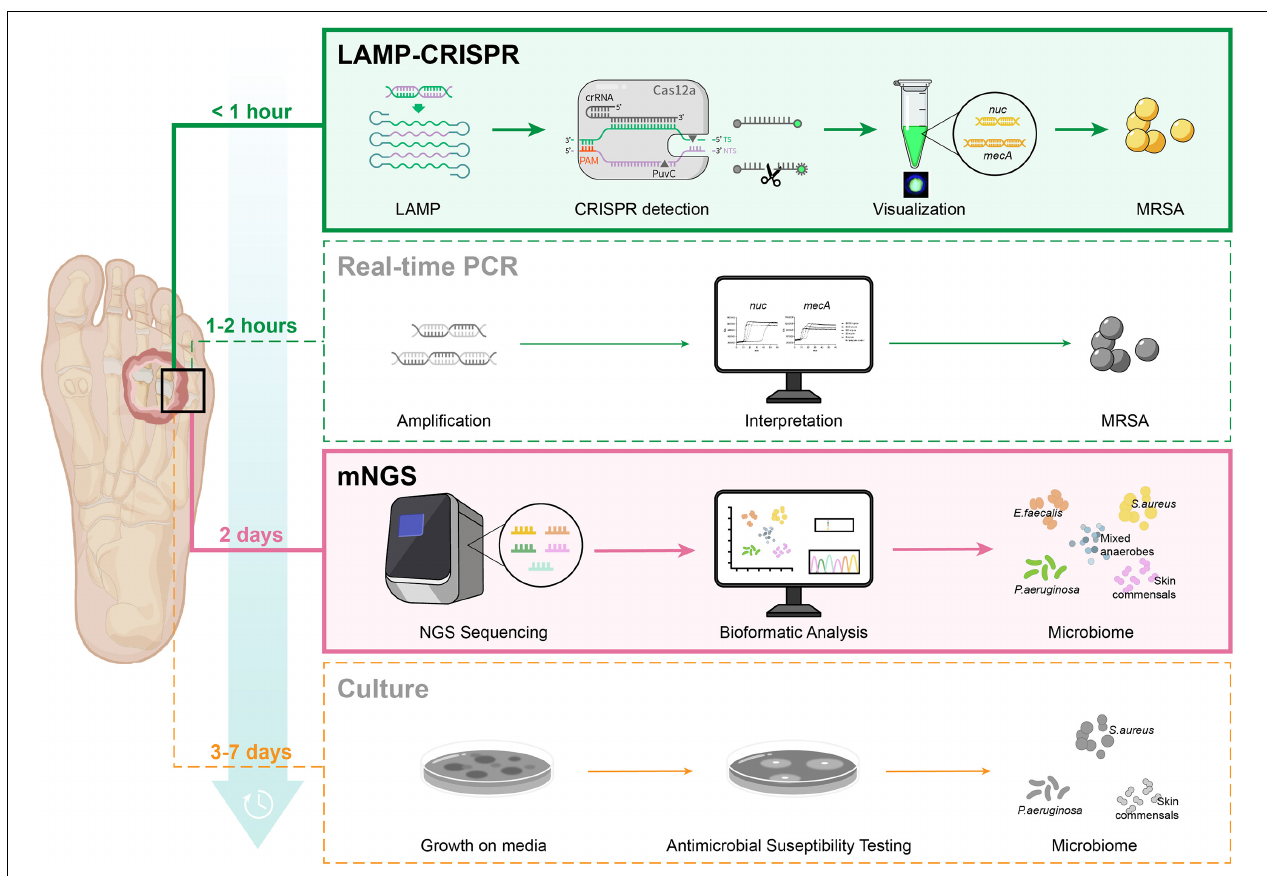
FIGURE 8 | Procedure of four diagnostic methods: LAMP-CRISPR assay, real-time PCR, mNGS, and reference culture.